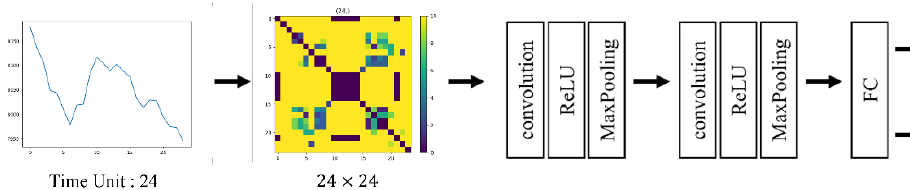
Figure 9. Proposed detecting anomaly method using time series images. Table 2. CNN-based model structure for binary classification.